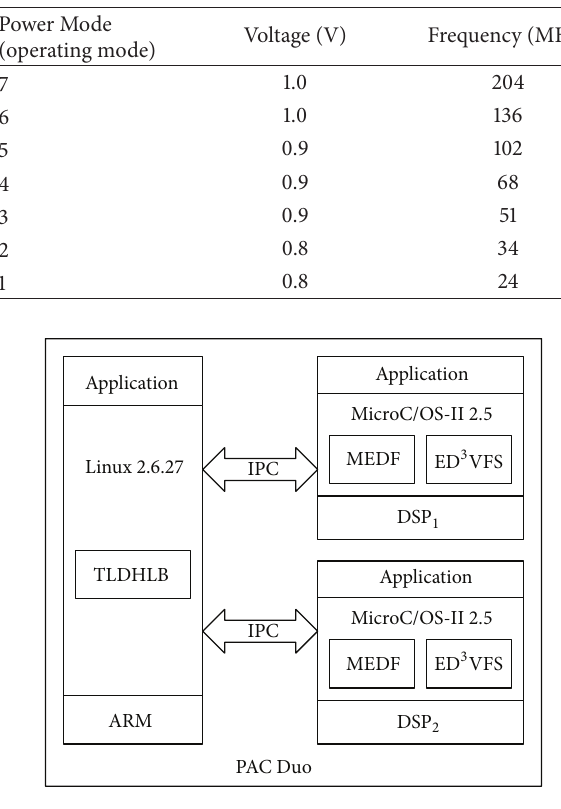
Figure 8: System architecture.